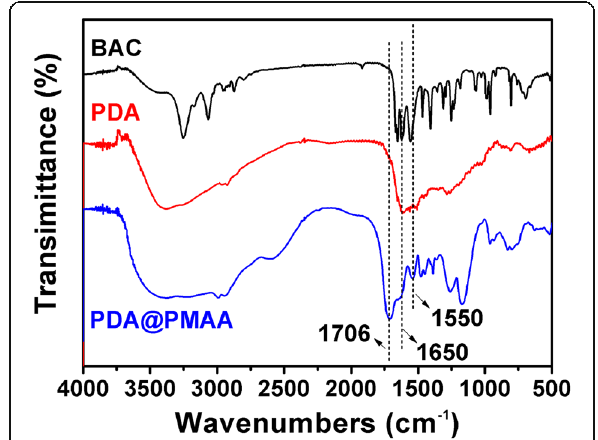
Fig. 4 FTIR spectra of BAC crosslinkers, PDA nanoparticles, and PDA@PMAA nanoparticles (from top to